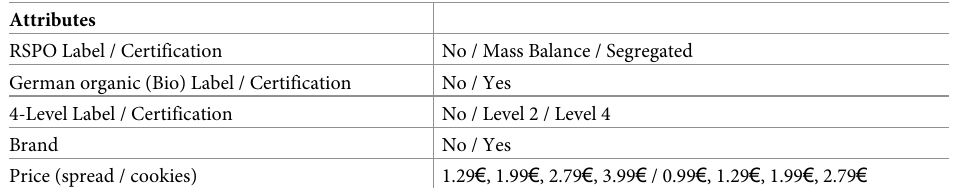
Table 1. Attributes and attribute level in the choice